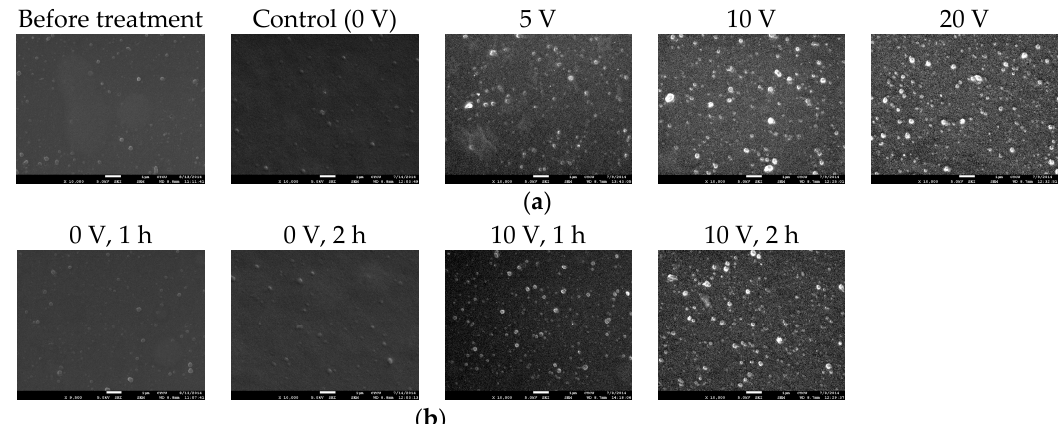
Figure 4. Scanning electron microscopy analysis of PEMs. ( a ) Surfaces of PEMs before or after treating different voltages for 1 h. ( b ) Surfaces of PEMs in aqueous environments with or without electrical field treatment for 1 or 2 h. (scale bar = 1 μ m).